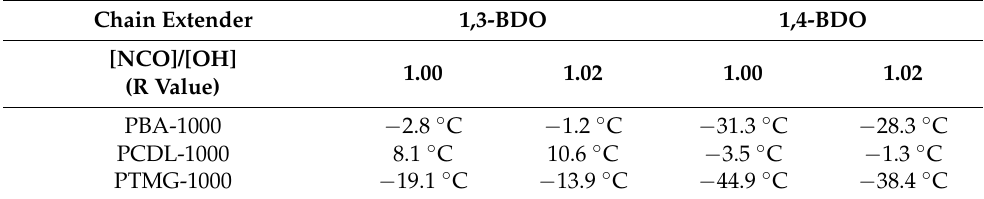
Table 4. The tan δ crest peak location on the DMA spectrum was used as the glass transition temper- ature (T g ). Relevant numerical values associated with TPU prepared through the polymerization of different butanediols with different R values. Chain Extender 1,3-BDO 1,4-BDO [NCO]/[OH] (R Value)